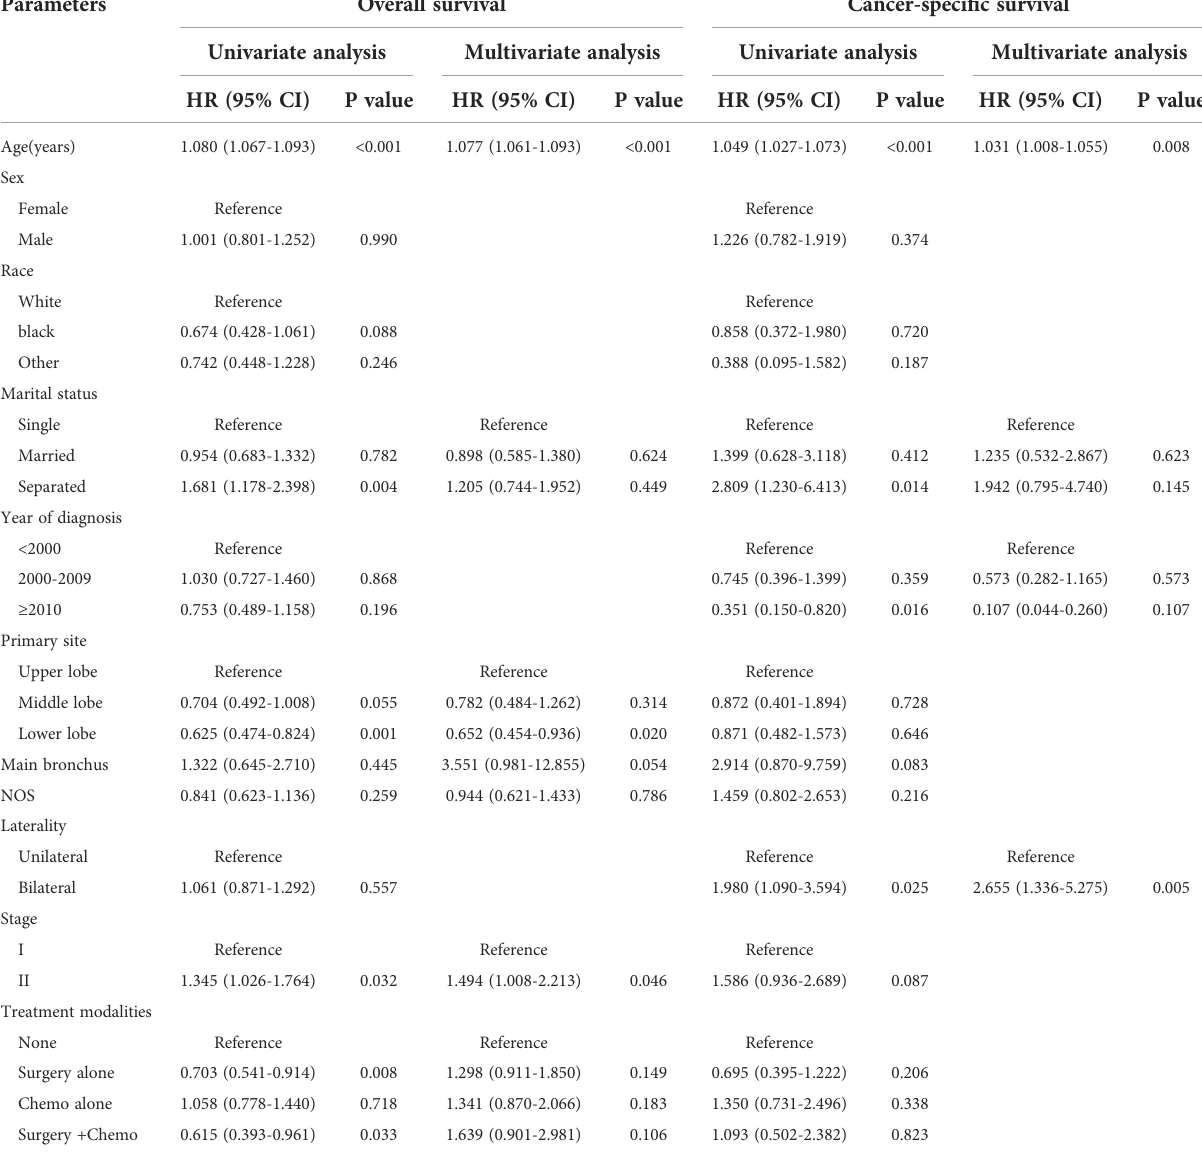
TABLE 3 Univariate and multivariate Cox regression analyses of overall survival and disease-speci fi c survival. Parameters Overall